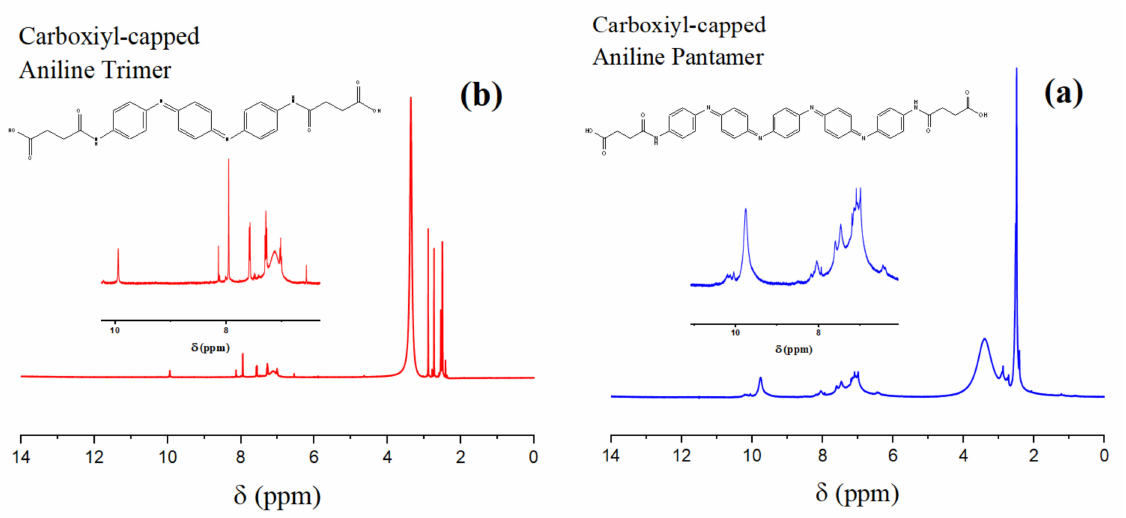
Figure 2. NMR spectra of the synthesized aniline oligomers ( a ) CAT and ( b ) CAP. The grafting of oligoanilines on the A-HNTs was confirmed by the peaks appearing at 3501 cm − 1 and 3512 cm − 1 for CAT-HNT and CAP-HNT, which were attributed to N–H stretching mode. The peaks at 1516 cm − 1 and 1523 cm − 1 for CAT-HNT and CAP-HNT, respectively, were related to C=C stretching vibration. The reduction in the peak intensity at 1670 cm − 1 and the appearance of a small peak at 1719 cm − 1 caused by the formation of amide groups (CONH) confirmed the reaction taking place between the carboxyl groups of oligoanilines and the amine groups of APTES present on the surface of HNTs [51]. Therefore, it can be concluded that the surface modification process performed on the halloysite nanotubes was effective and the target layers were successfully formed as shells on the surface of the